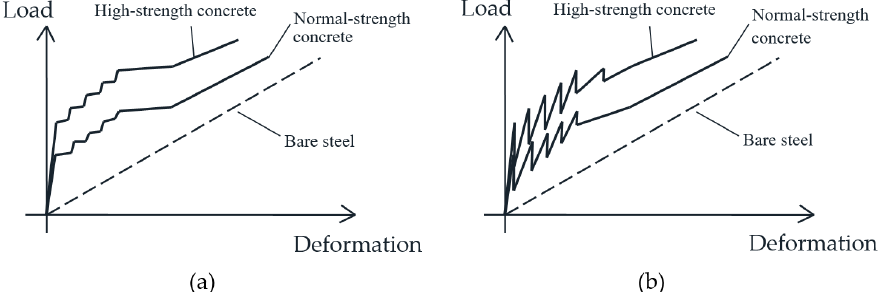
Figure 7. Differences in load-deformation diagrams of tension members subjected to imposed load ( a ) or imposed displacement ( b ) [38].